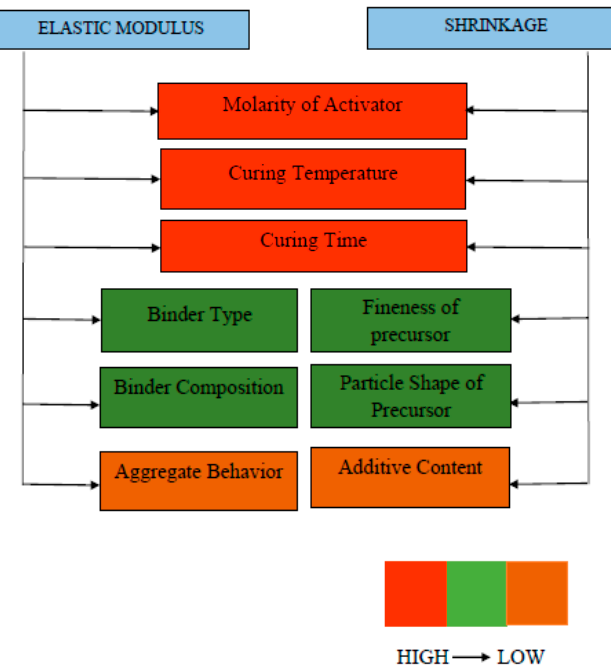
Figure 22. Contributing factors to elastic modulus and shrinkage.